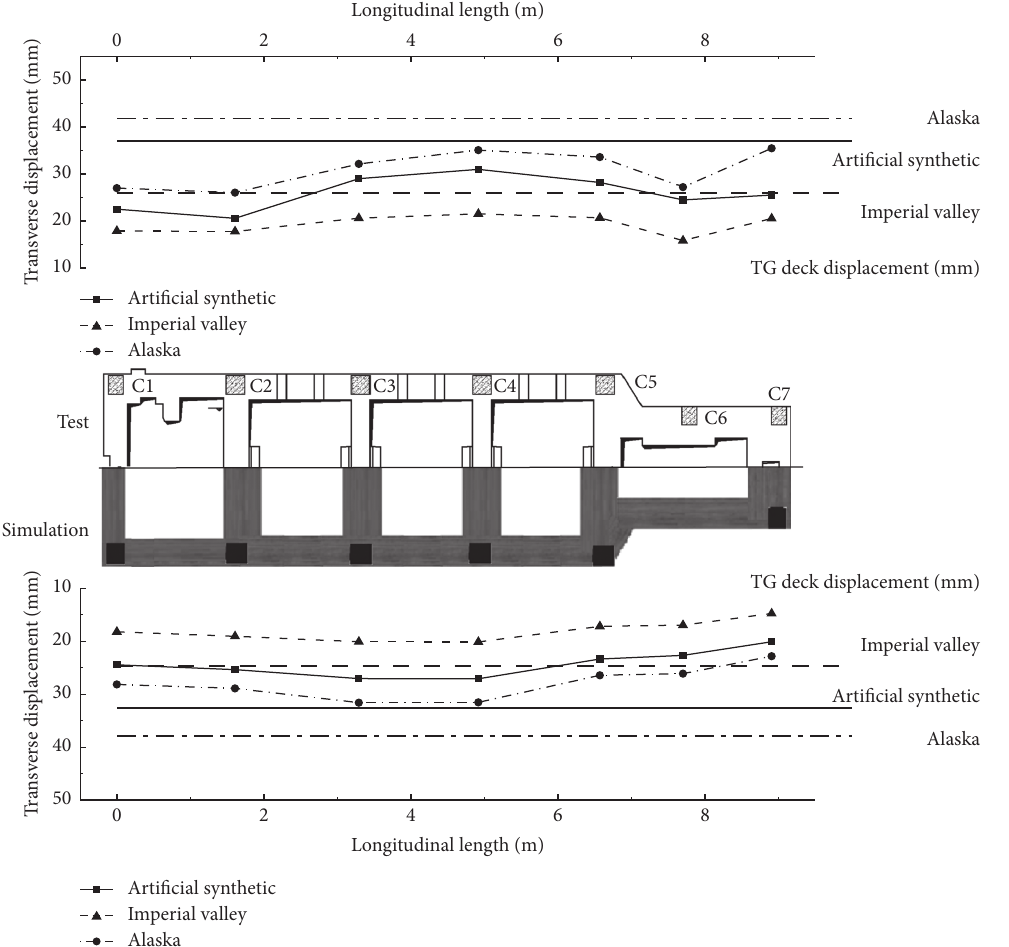
Figure 15: Displacement seismic response contrast of TG deck and column